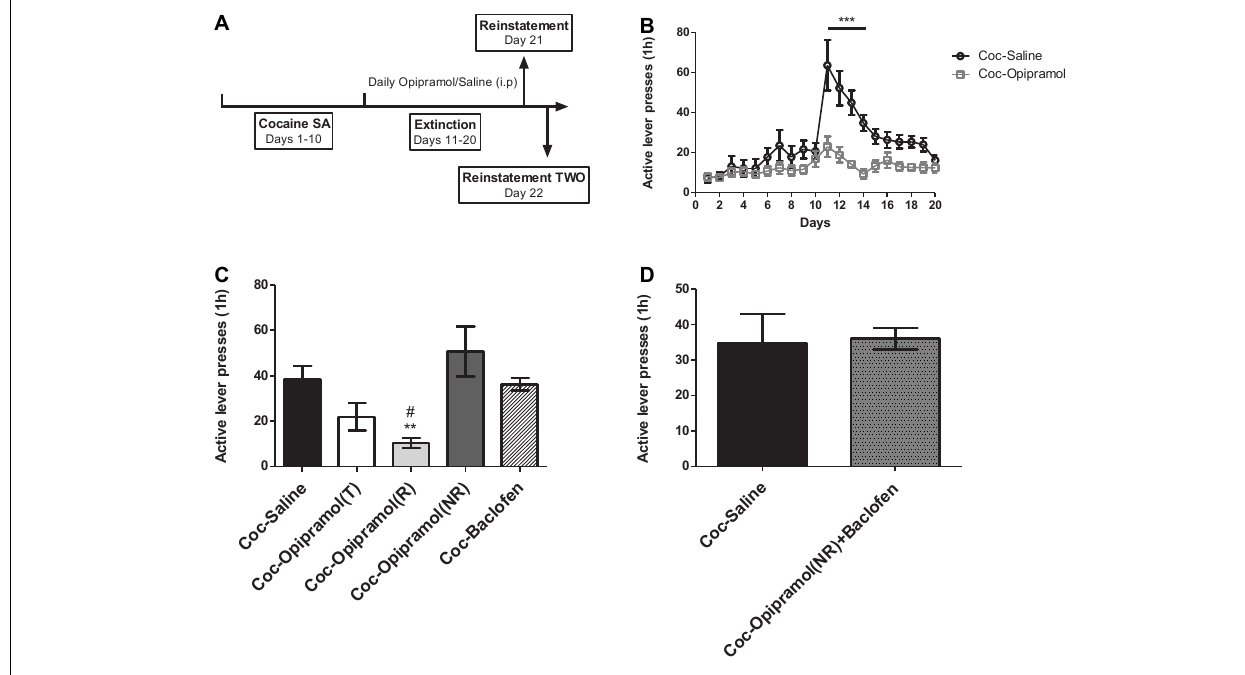
FIGURE 2 | Effect of opipramol (12.5 mg/kg) and low doses of baclofen (0.1 mg/kg) on extinction, withdrawal and reinstatement phases in a cocaine (Coc) self-administration (SA) rat model. (A) The fixed ratio 1 schedule (FR-1) of cocaine SA model that was used. Rats ( n = 10–14) were trained (T) for cocaine (0.5 mg/kg) or saline SA on days 1–10. Next, we created two groups: Coc-Saline, control, trained for cocaine SA and received saline at the withdrawal phase, and Coc-Opipramol, trained for cocaine SA and received opipramol (12.5 mg/kg) throughout the withdrawal phase. (B) Effect of opipramol on cocaine-seeking